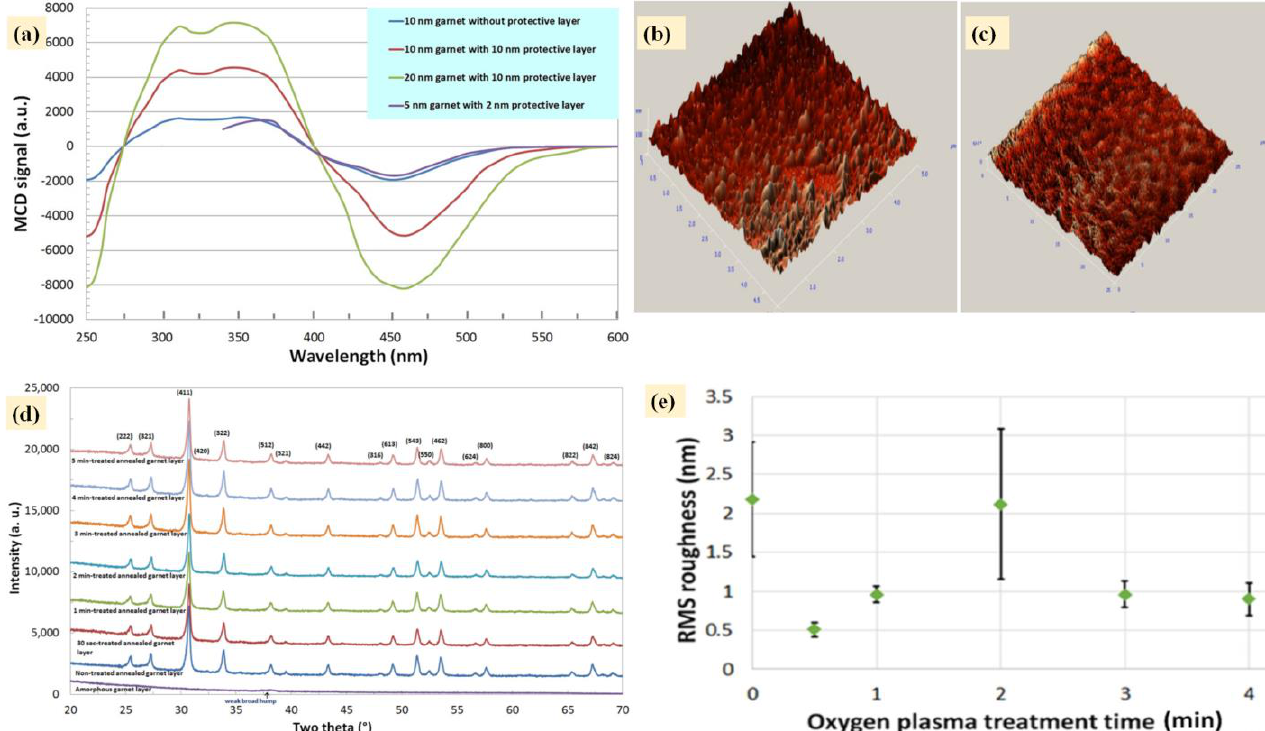
Figure 9. Observed MCD signals from garnet layers prepared under protective layers ( a ), microstructural properties of garnet-oxide composite ( b , c ), XRD data, and RMS roughness properties of post-deposition oxygen plasma treated garnet layers followed by optimized annealing crystallization ( d , e ) [13,38].